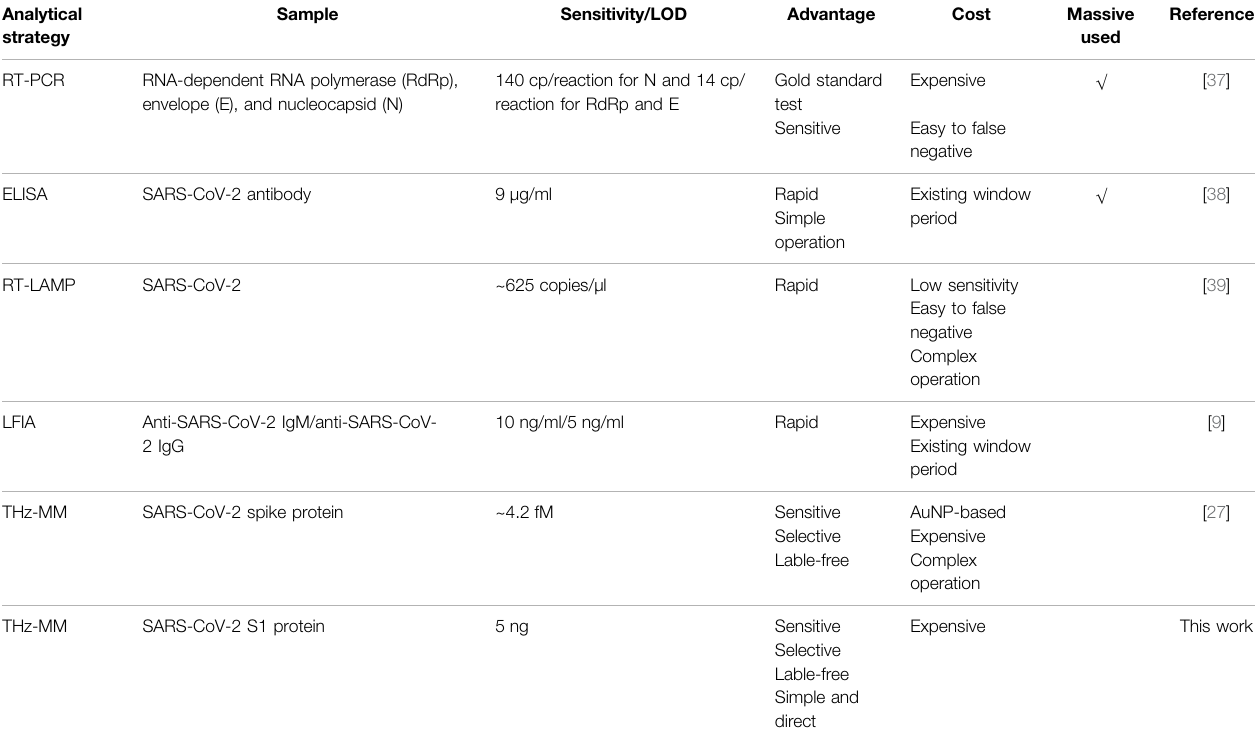
TABLE 3 | Comparison of current strategies for SARS-CoV-2 detection. Analytical